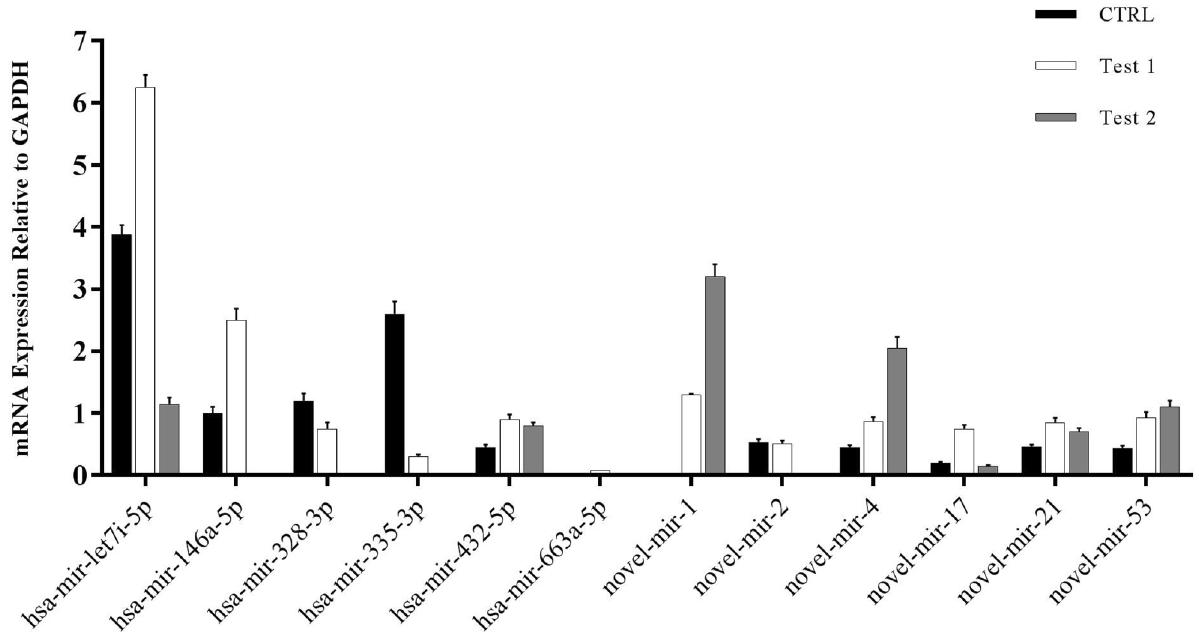
Figure 8. The qRT-PCR analysis of miRNA expression. The qRT-PCR technique was used to verify and measure the expression levels of six conserved miRNAs and six novel miRNAs in Control, Test 1 and Test 2 groups. The qRT-PCR results revealed that all tested miRNAs were detected similar to what illustrated by the performed high-throughput sequencing analysis. However, the expression levels of hsa-miR-432-5p, hsa-miR- 335-3p, novel-miR-2, and novel-miR-21 were different from the achieved sequencing outcomes. Values are expressed as the mean ±